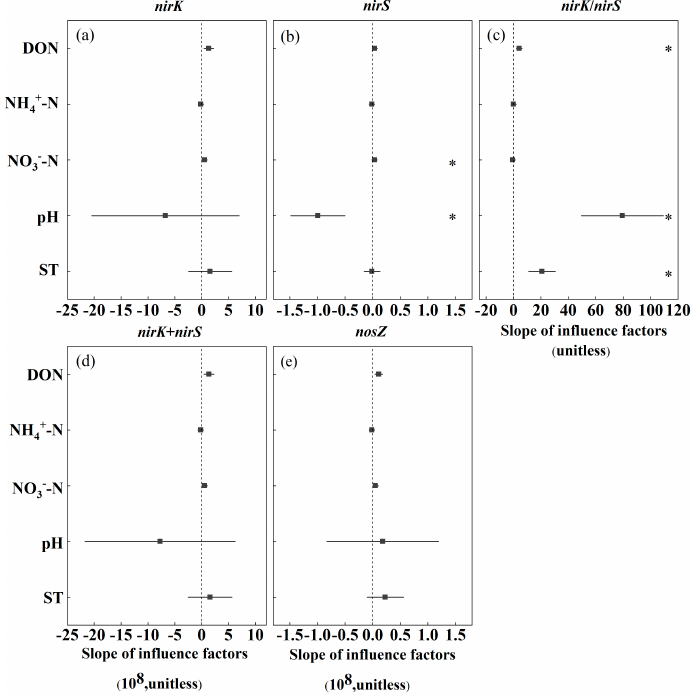
Figure 5. Slope of influencing factors of the ( a ) nirK gene; ( b ) nirS gene; ( c ) nirK / nirS ; ( d ) nirK gene + nirS gene; and ( e ) nosZ gene. Note: * Significant at the 0.05 probability level.